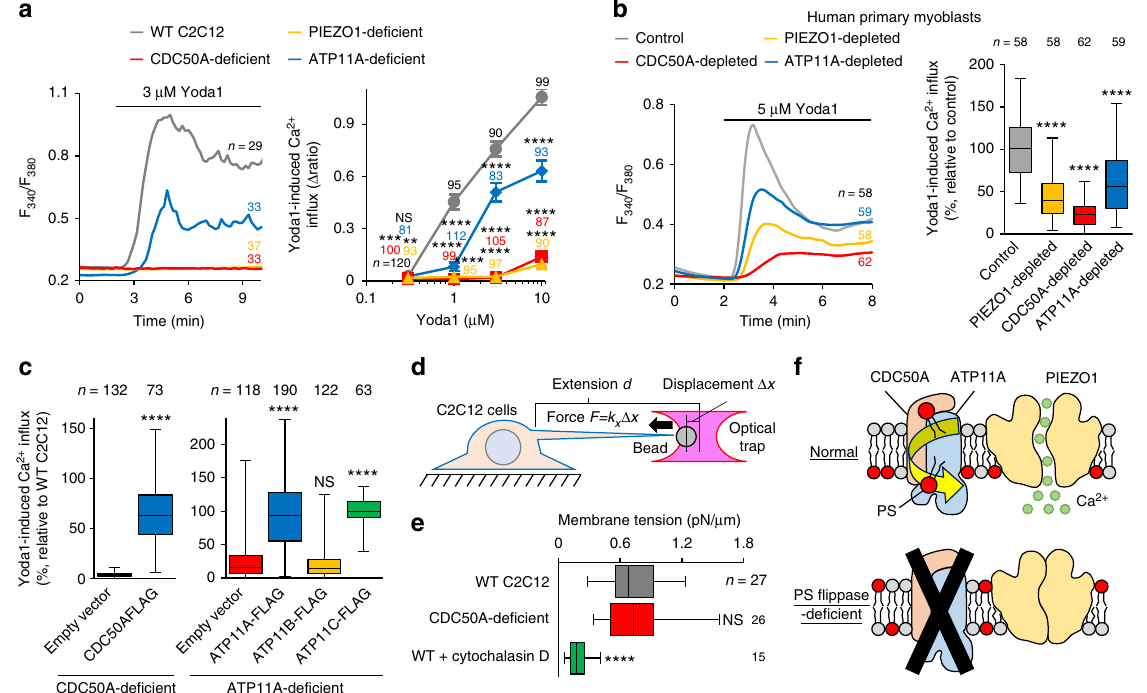
Fig. 3 Impaired PIEZO1 activation in PS fl ippase-de fi cient myoblasts. a , b Suppression of agonist-induced PIEZO1 activation by PS fl ippase de fi ciency. a Left: Fura2 ratiometric measurements (F 340 /F 380 ) of Yoda1-induced Ca 2 + in fl ux in WT, PIEZO1-de fi cient, CDC50A-de fi cient, and ATP11A-de fi cient C2C12 myoblasts. Right: quanti fi cation of Yoda1-induced Ca 2 + in fl ux as the maximal increment of F 340 /F 380 ( Δ ratio) in left. b Left: Fura2 ratiometric measurements of Yoda1-induced Ca 2 + in fl ux in human primary myoblasts transfected with control, PIEZO1, CDC50A or ATP11A siRNA. Right: quanti fi cation of Yoda1-induced Ca 2 + in fl ux in left. c Rescue of agonist-induced PIEZO1 activation in PS fl ippase-de fi cient myoblasts by overexpression of PS fl ippase complex components. Quanti fi cation of Yoda1-induced Ca 2 + in fl ux in CDC50A-de fi cient (left) or ATP11A-de fi cient (right) C2C12 myoblasts expressing FLAG-tagged CDC50A, ATP11A, ATP11B or ATP11C. d , e Normal plasma membrane tension in PS fl ippase-de fi cient myoblasts. d Schematic model of membrane tension measurement using an optical trap. e Quanti fi cation of membrane tension in WT, CDC50A-de fi cient and cytochalasin D- treated WT C2C12 cells. f Schematic model showing PS fl ippase-mediated inward translocation of cell surface-exposed PS as a prerequisite for PIEZO1 activation. ** P < 0.01, *** P < 0.001, and **** P < 0.0001 (Student ’ s t -test). NS not signi fi cant, n sample number. Box and whiskers graph ― line: median, box: upper and lower quartiles, whiskers: maxima and